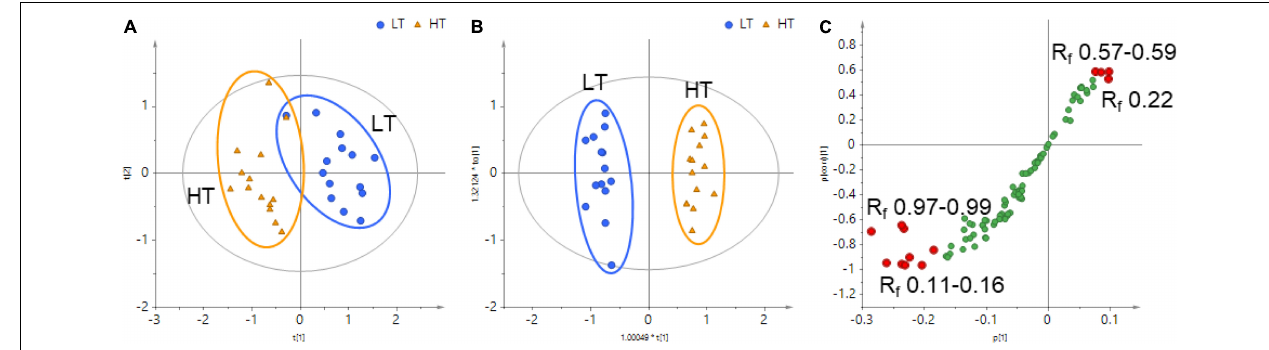
FIGURE 3 | (A) Principal component analysis (PCA) score plot, (B) orthogonal partial least square-discriminant analysis (OPLS–DA) score plot, and (C) OPLS–DA S-plot of HT and LT samples based on the data extracted from the whole HPTLC chromatograms. The variables contributing most to the differences were highlighted with red-filled circles.